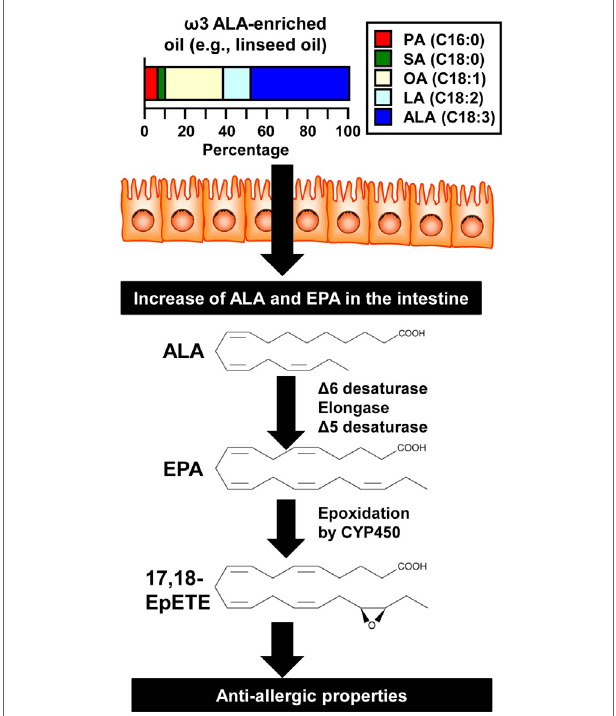
FiGURe 1 | Metabolic pathway in the generation of anti-allergic/ inflammatory lipid mediators from the dietary oil. ALA is enriched in some kinds of dietary oil (e.g., linseed oil) and absorbed into the intestinal tissues where it is metabolized into EPA after several reactions mediated by various enzymes (e.g., elongase and desaturases). EPA is epoxidized by CYP450 to generate 17,18-EpETE, which exerts anti-allergic properties in the intestine. Abbreviations: ALA, α -linolenic acid; CYP, cytochrome P450; EPA, eicosapentaenoic acid; EpETE, epoxy eicosatetraenoic acid; LA, linoleic acid; OA, oleic acid; PA, palmitic acid; SA, stearic